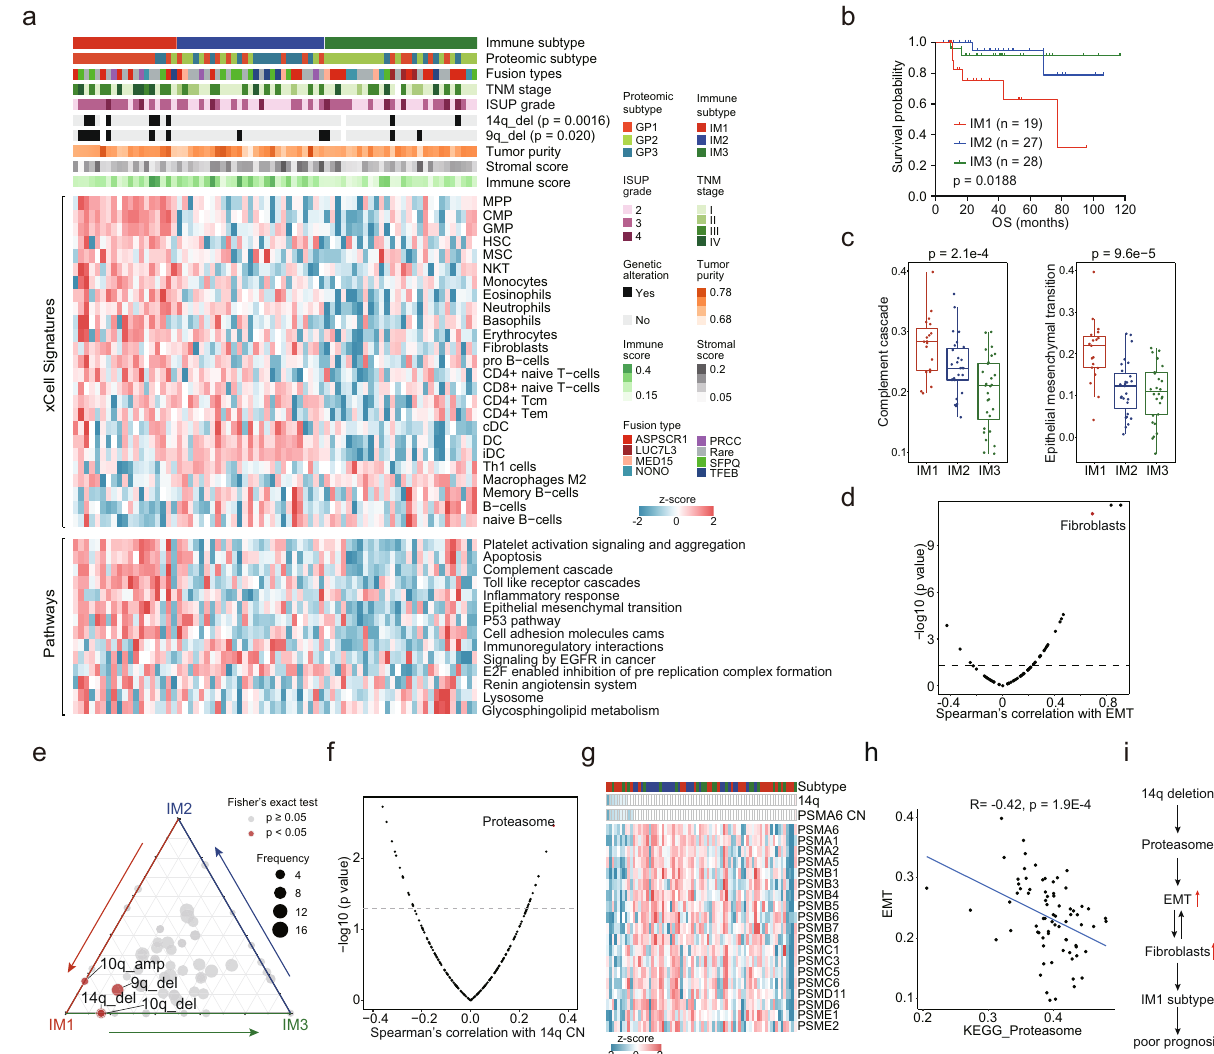
Fig. 7 | Immune in fi ltration of tRCC tumors. a Relative abundances of upregu- latedproteinsinthethree immune subtypes and associations of immune subtypes with clinical and genetic features and proteomic subtypes (Fisher ’ s exact test). b Kaplan – Meier curves of OS for the three immune subtypes (two-sided log-rank test). c Comparison of pathway scores for the Complement Cascade and EMT among immune subtypes (IM1, n =19; IM2, n =27; IM3, n =28). Boxplots show the median (central line), the 25 – 75% IQR (box limits), and the ±1.5×IQR (whiskers). P values are derived from Kruskal – Wallis test. d Scatter plot showing the correlation